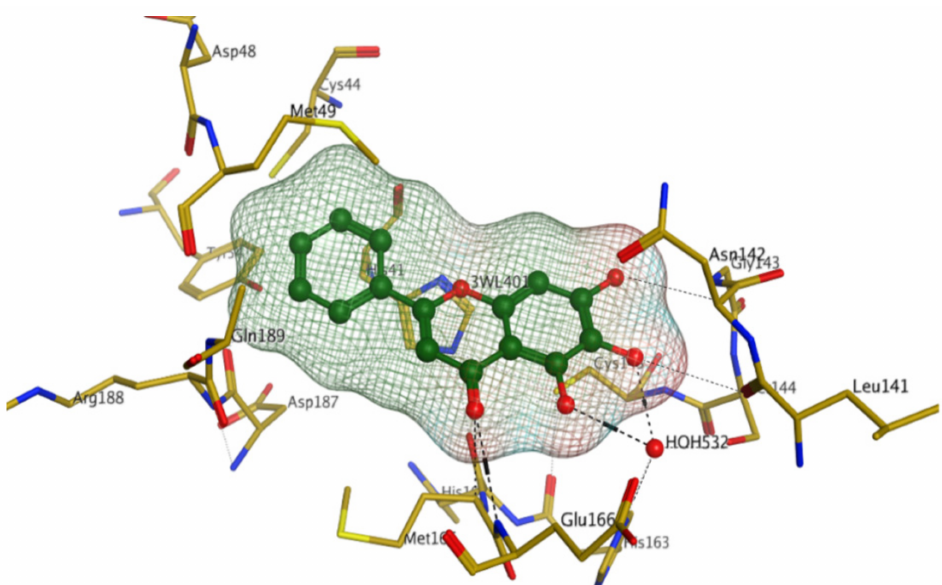
Figure 4. The binding interactions (black-dashed lines) between baicalein (green sticks) and the surrounding key amino acid residues (mustard yellow) of the active site in the main protease (Mpro) of SARS-CoV-2 (PDB: